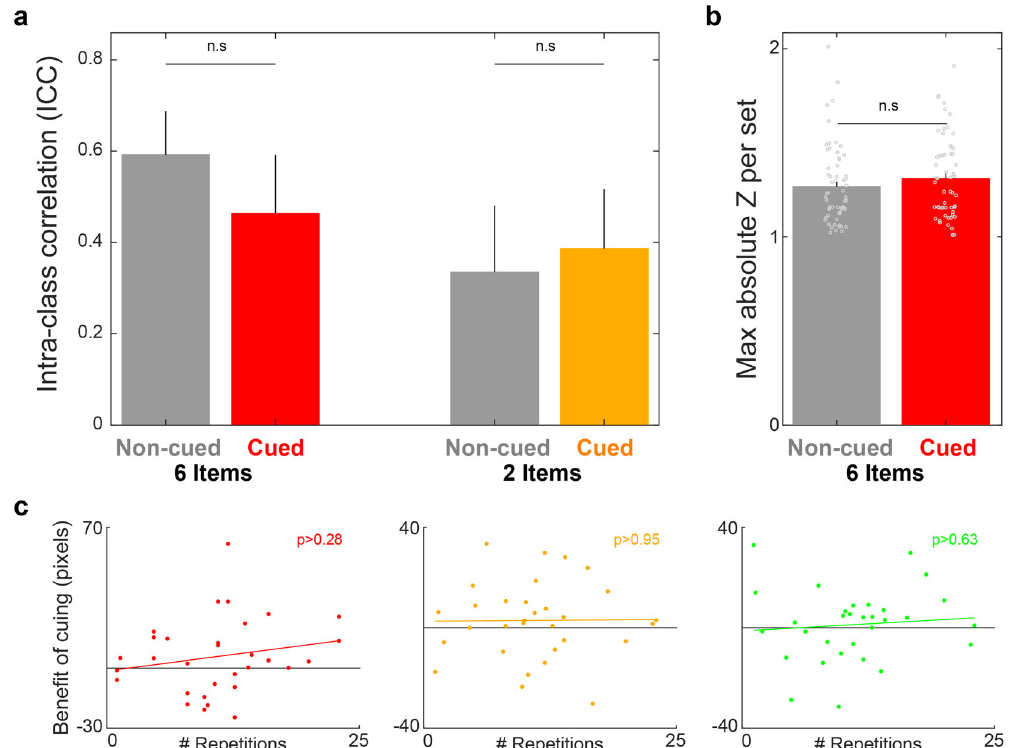
Fig. 3 Models predicting that a subset of items bene fi ts from reactivation are not supported by the behavioral data. a If a small subset of items were to bene fi t from cuing in a biased manner (i.e., biased subset reactivation model), we would expect signi fi cantly higher interclass correlations between bene fi ts of individual items for non-cued sets relative to cued sets, but no such effect was observed. b Another prediction of the biased subset reactivation model is that the cued sets would be more prone to outlier-like results (e.g., a single item ’ s bene fi t would be much higher than the others ’ ). Comparisons between the maximal absolute Z -score within set for cued and non-cued sets of six items failed to show a signi fi cant difference on this measure. c If a small subset of items randomly bene fi ted from each presentation (i.e., random subset reactivation model), we would expect that more repetitions per cue would result in larger bene fi ts of cuing to memory (relative to non-cued items), but these correlations were not signi fi cant for any set size (red – six-item sets; yellow – two-item sets; and green – one-item sets). Error bars signify standard error of the mean. n.s. nonsigni fi cant